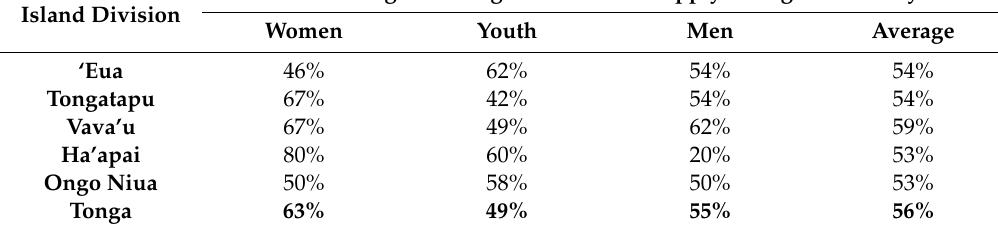
Table 10. The percentage of villages in each Island Division that identified water supply issues as first priority in terms of women’s, youths’ and men’s perspectives.